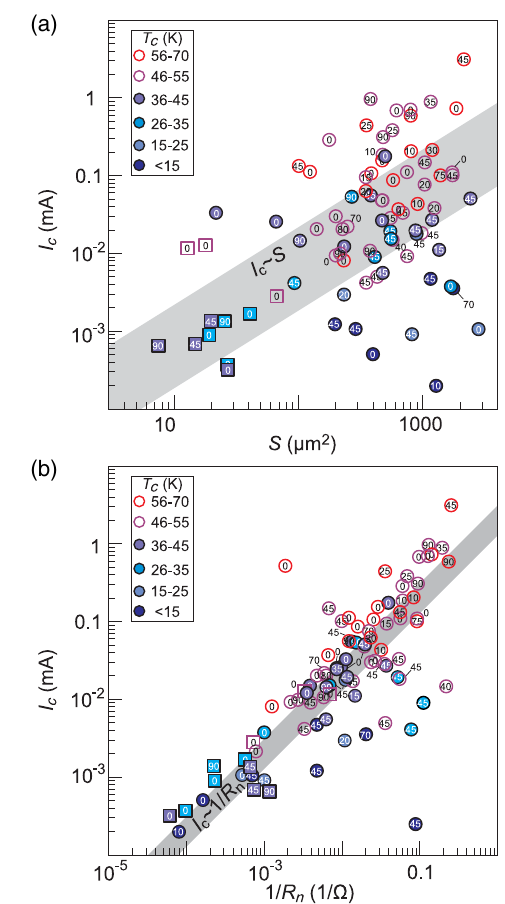
FIG. 8. (a) Josephson critical current I c as a function of the physical area of the junction. (b) I c as a function of the inverse normal state resistance 1 =R n . All data points are obtained from I - V measurements at 1.6 K. Numbers inside or close to the symbols indicate the nominal twist angles. Thick gray bandlike backgrounds in (a) and (b) represent the linear dependence. Squares represent data obtained from samples with small junction areas, which are realized by focused ion beam etching.